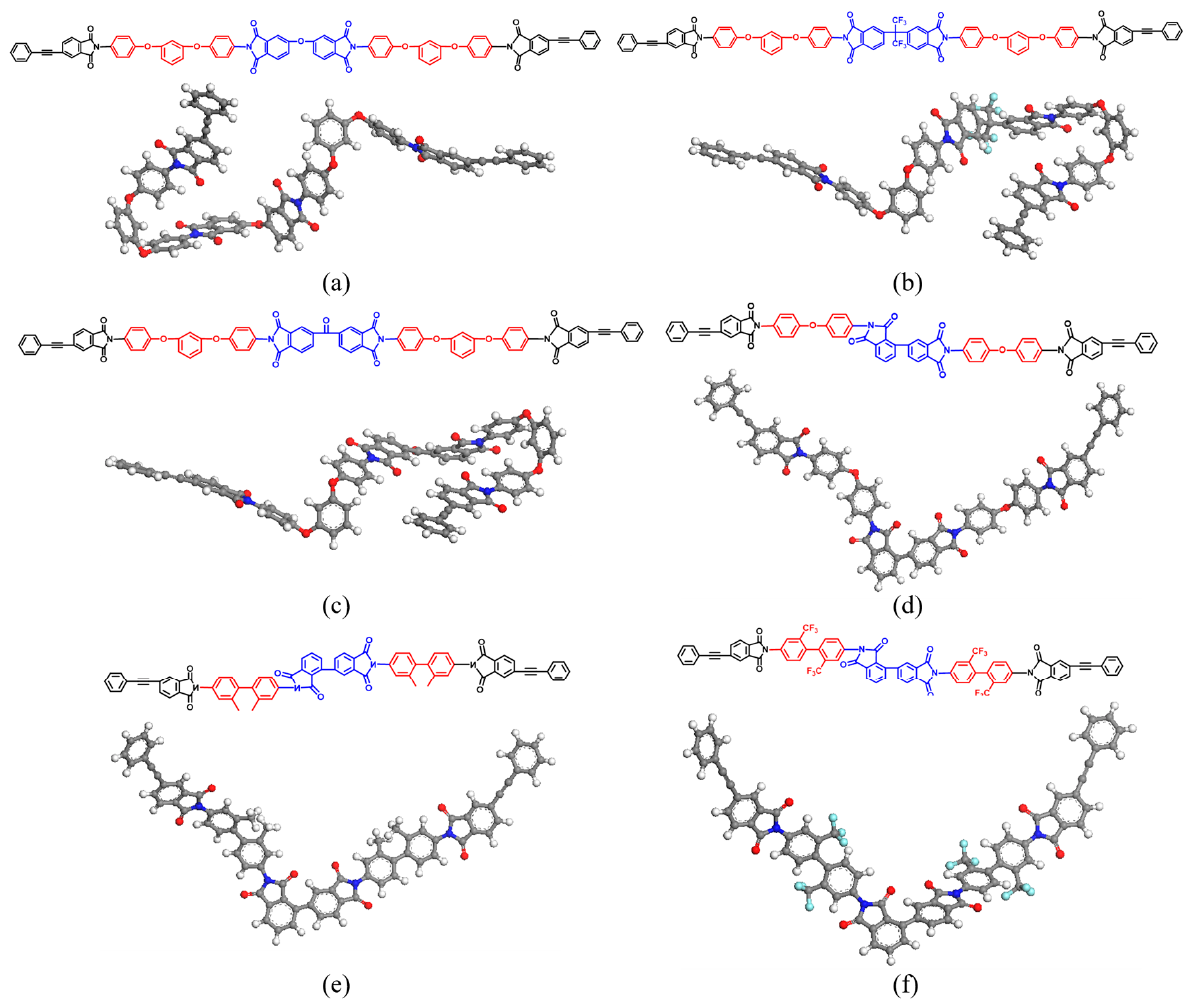
Figure 1. ( a – f ) Molecular structures of the oligomers.